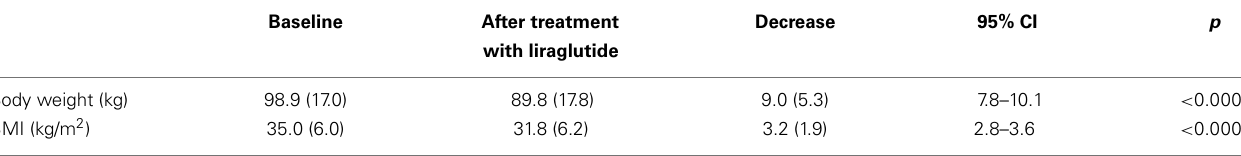
Table 1 | Changes in body weight and BMI after treatment with liraglutide in overweight and obese women with PCOS . Baseline After treatment